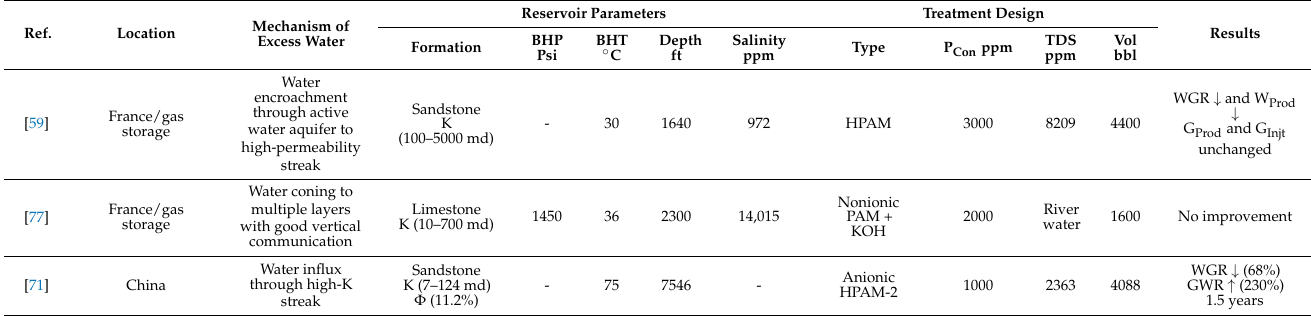
Table 11. Polymer systems—water shutoff treatments in gas production wells